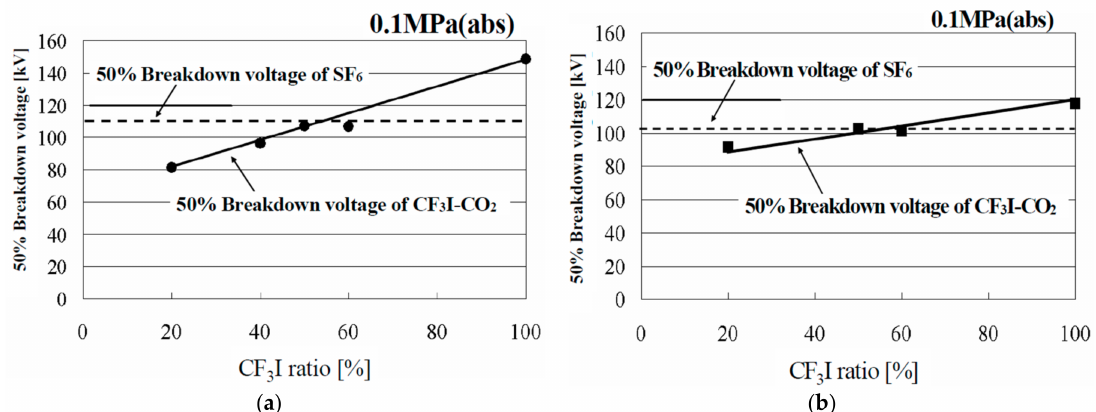
Figure 3. Breakdown voltage characteristics of CF 3 I-CO 2 mixtures in a sphere-sphere electrodes geometry in positive ( a ) and negative ( b ) polarity: the diameter of sphere is 50.8 mm and the electrode gap is 10 mm [34]; the y -axis indicates the absolute values of 50% breakdown voltage.